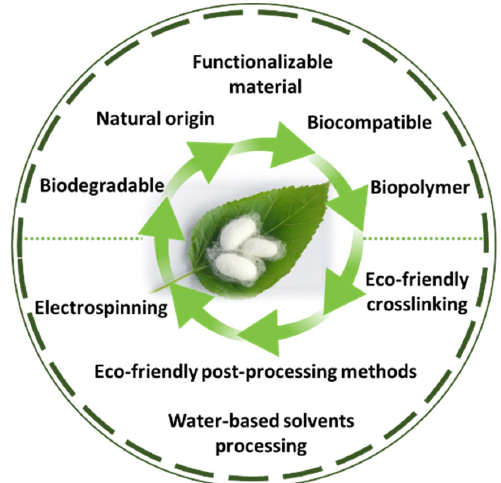
Figure 3. The main properties and methods of processing SF as a green material.